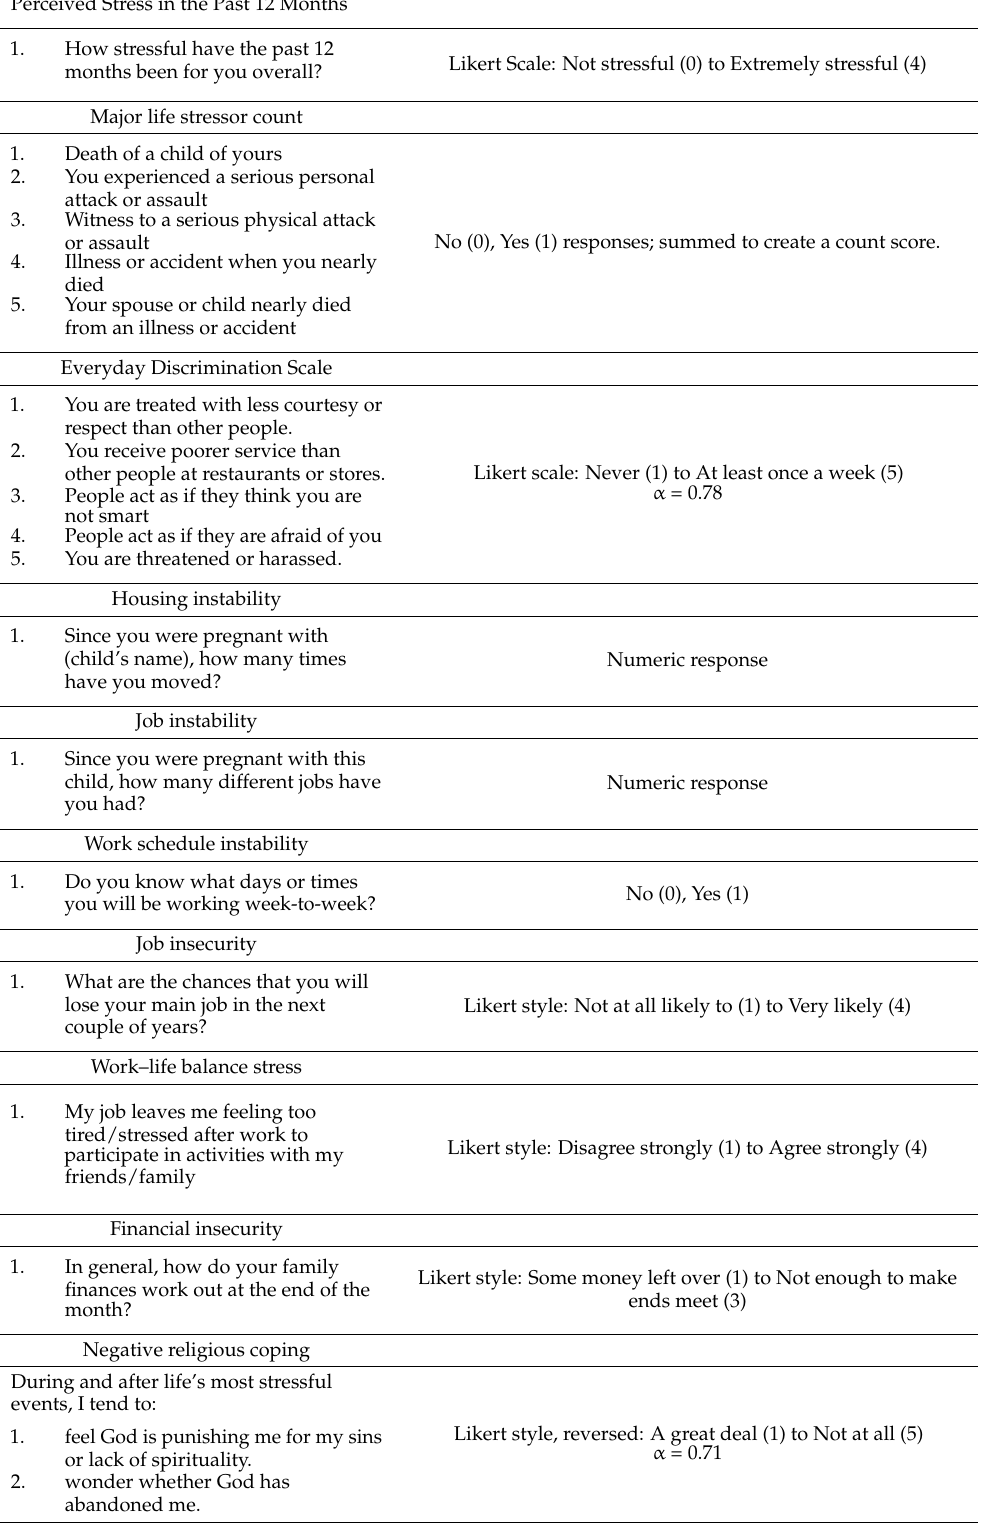
Table 1. Measures of